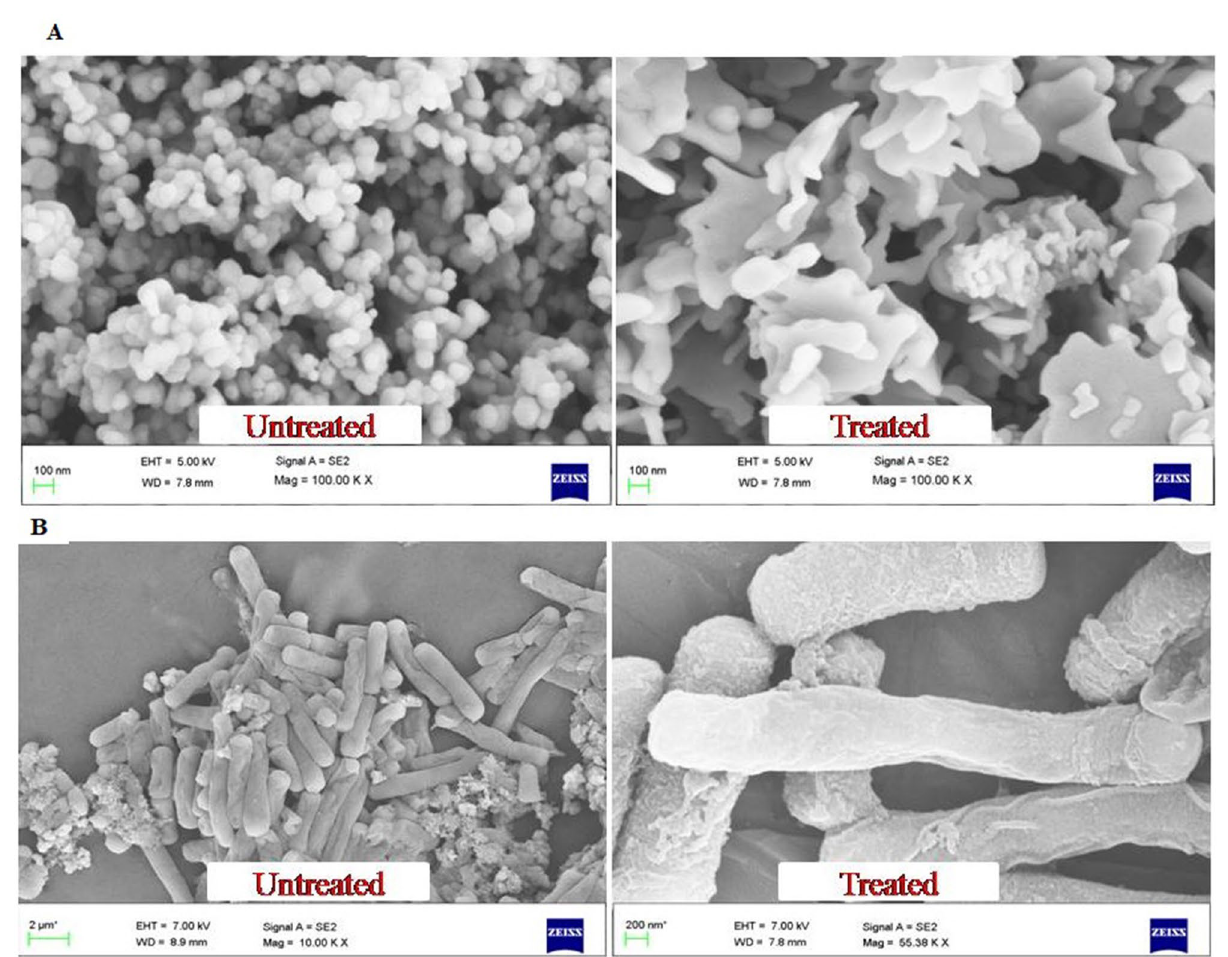
Figure 11. FE-SEM image of rapid synthesized SeNPs treated and untreated pathogenic bacteria in ( A ) B. subtilis and ( B ) E. coli